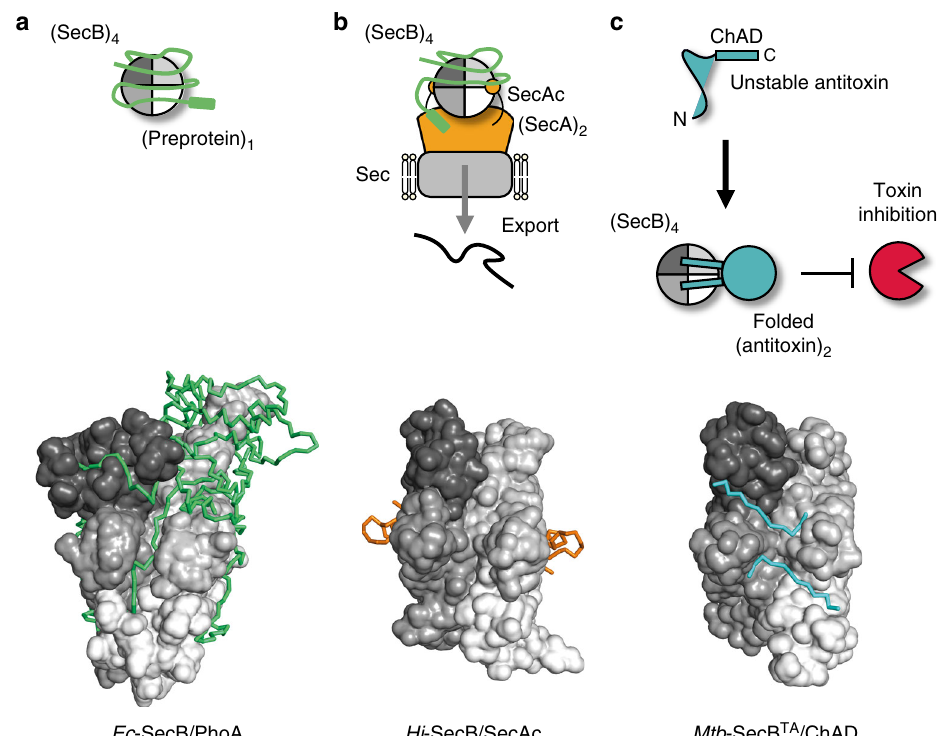
Fig. 6 High structural plasticity of SecB proteins favors ligand avidity. Model showing the different SecB-binding modes based on NMR and X-ray data. a SecB displays robust antifolding activity when bound to presecretory protein clients as illustrated by the Ec -SecB/PhoA structure, b SecB binds to its SecA partner to perform protein export as illustrated by the Hi -SecB/SecAc structure, and c SecB associated with TA systems binds to the chaperone addiction region of the antitoxin (ChAD), facilitating its folding and subsequent toxin inhibition. The oligomeric states of the different proteins are indicated